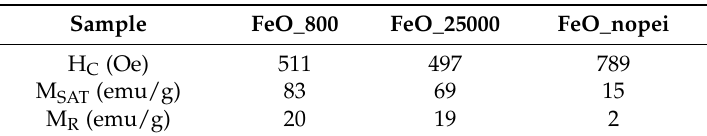
Table 1. Magnetic parameters measured at 4 K from hysteresis loops of samples FeO_800, FeO_25000, and FeO_nopei, respectively. H C : coercive field, M SAT : saturation magnetization, M R : remnant magnetization (remanence).